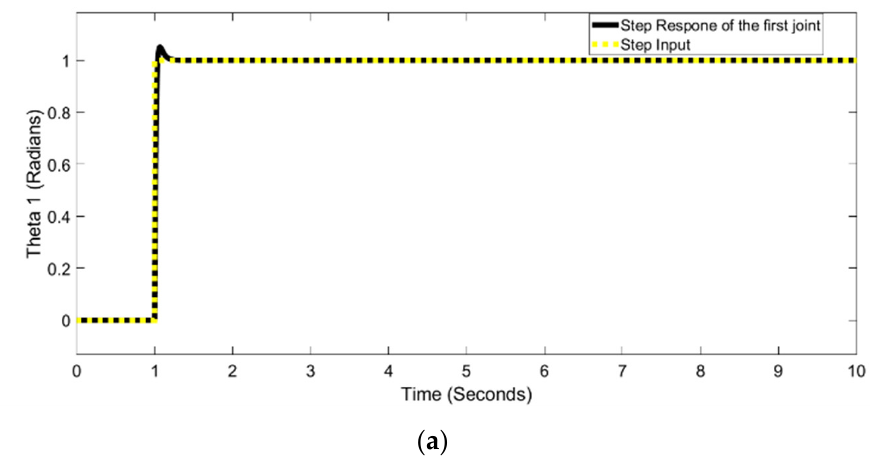
Figure 17. The dynamic model of the actuator module of the exoskeleton SAMA.